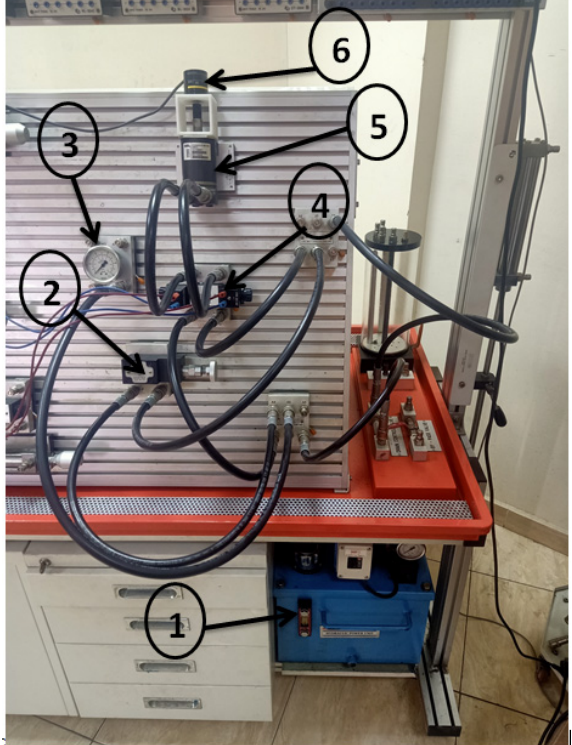
Figure 10. A hydraulic circuit is set up to measure the hydraulic motor speed. (1) hydraulic tank. (2) relief valve. (3) pressure gauge. (4) solenoid valve. (5) hydraulic motor. (6) rotary